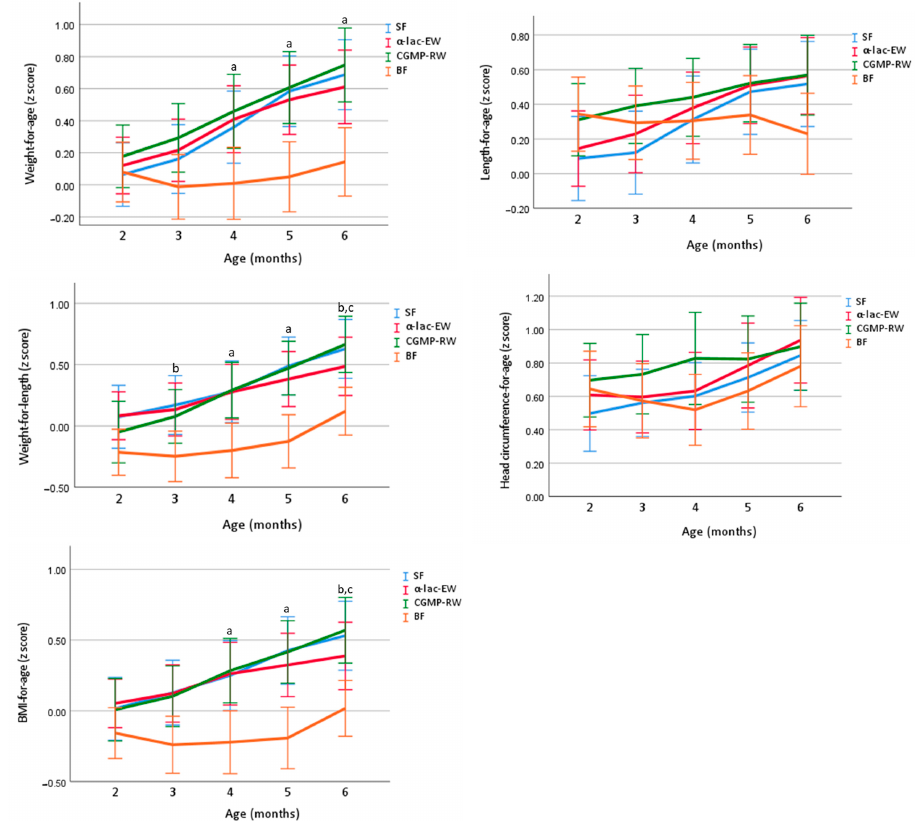
Figure 2. Unadjusted mean (95% CI) of z-score weight-for-age (WAZ), length-for-age (LAZ), weight-for-length (WLZ), HC-for-age (HCAZ) and BMI-for-age (BMIZ) in study groups compared by one-way ANOVA, post hoc Bonferroni. a all FF groups significantly different vs. BF. b SF significantly different vs. BF. c CGMP-RW significantly different vs. BF. SF, standard formula; α -lac-EW, experimental formula with α -lactalbumin-enriched whey; CGMP-RW, experimental formula with reduced CGMP whey; BF, breast-fed.